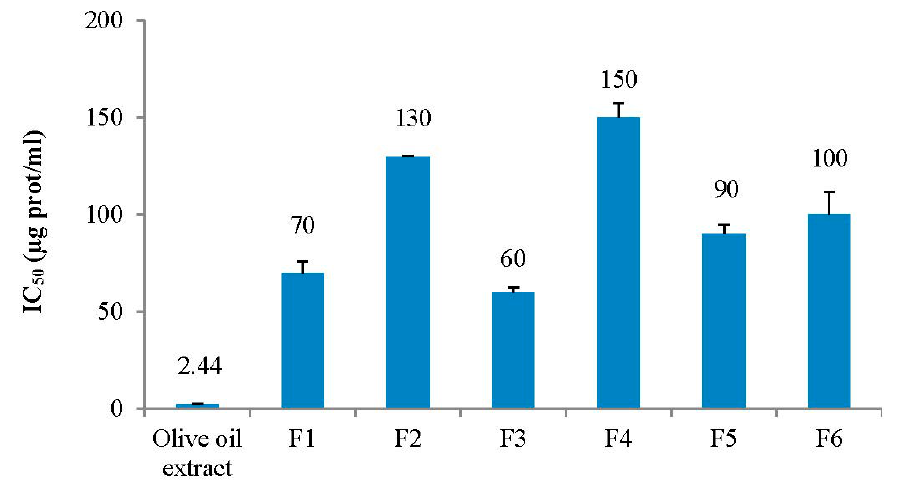
Figure 2. Angiotensin-converting enzyme (ACE) inhibitory activity (expressed as IC 50 ) of water-soluble unfiltered virgin olive oil extract and of the fast protein liquid chromatography (FPLC)-purified fractions F1–F6. Data are expressed as mean values ± SD (bars).